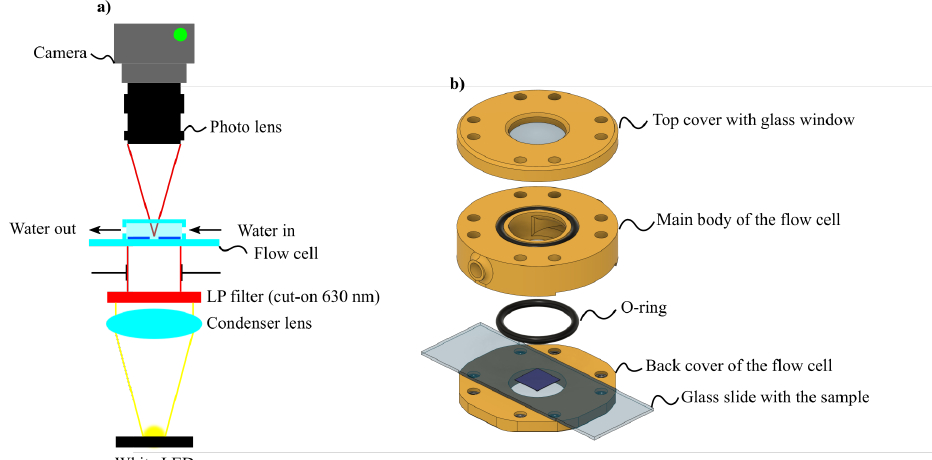
Figure A1. ( a ) Optical schematics of a modified transmission microscope. ( b ) 3D view of a custom designe flow cell to conduct the MB elution study under the high flow conditions.